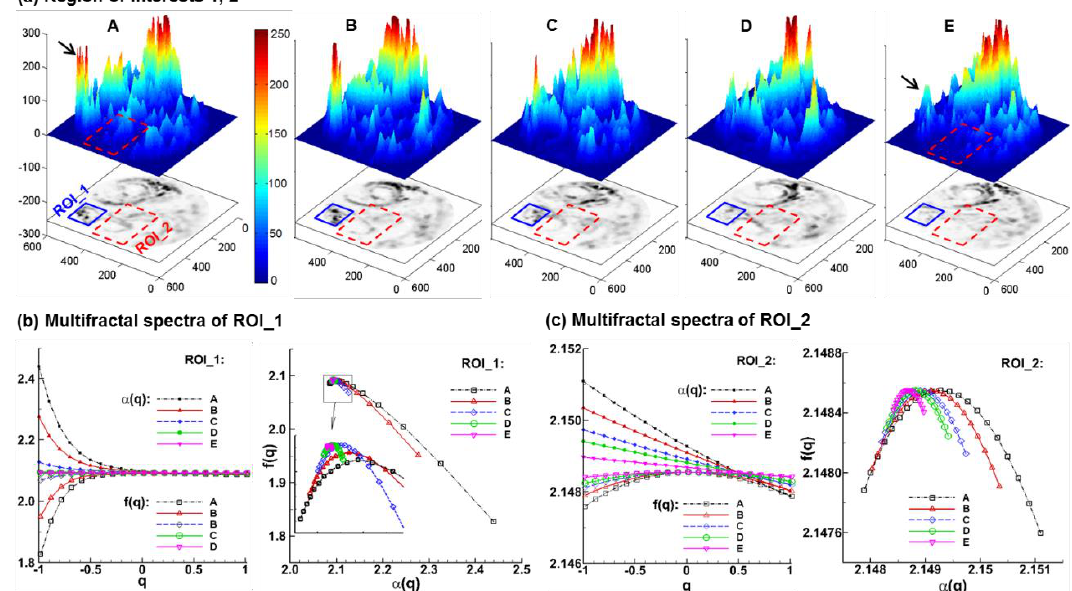
Figure 10. Multifractal spectrum analysis in the test case 2: ( a ) 3D plot of aerosol concentrations; ( b ) comparison of the multifractal spectra in ROI_1 across the five tumor stages (A–E); ( c ) comparison of the multifractal spectra in ROI_2 across five tumor stages.